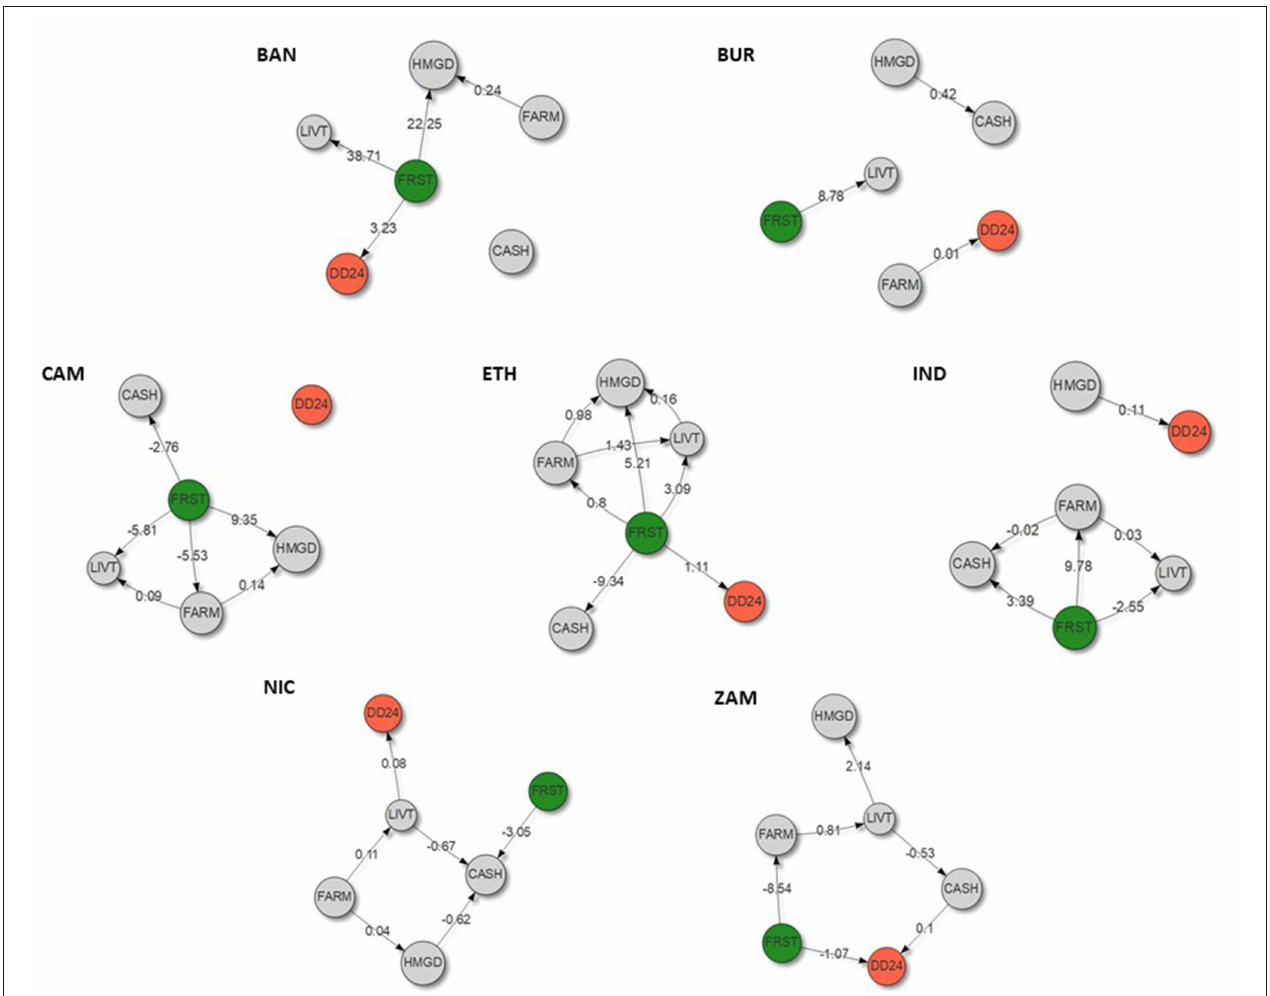
FIGURE 4 | Piece-wise structural equation models linking the percentage of forest in a 2-km radius surrounding each household (FRST) to its household dietary diversity score recorded over the past 24h (DD24) for Bangladesh (BAN), Burkina Faso (BUR), Cameroon (CAM), Ethiopia (ETH), Indonesia (IND), Nicaragua (NIC), and Zambia (ZAM). Only relationships that are statistically significant ( P < 0.1) are represented with their coefficient in the networks. FARM: farm size (ha), HMGD: presence/absence of a home garden, LIVT: livestock ownership (TLU or presence/absence), CASH: integration or not to the cash